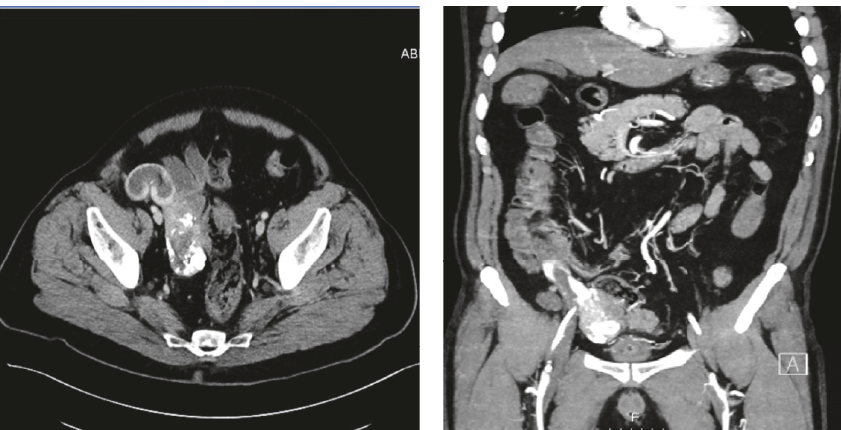
Figure 3: Axial and coronal CT angiography of the abdomen showing a calcified mass at the right pelvis, attached to the distal ileum with intraluminal contrast blush.